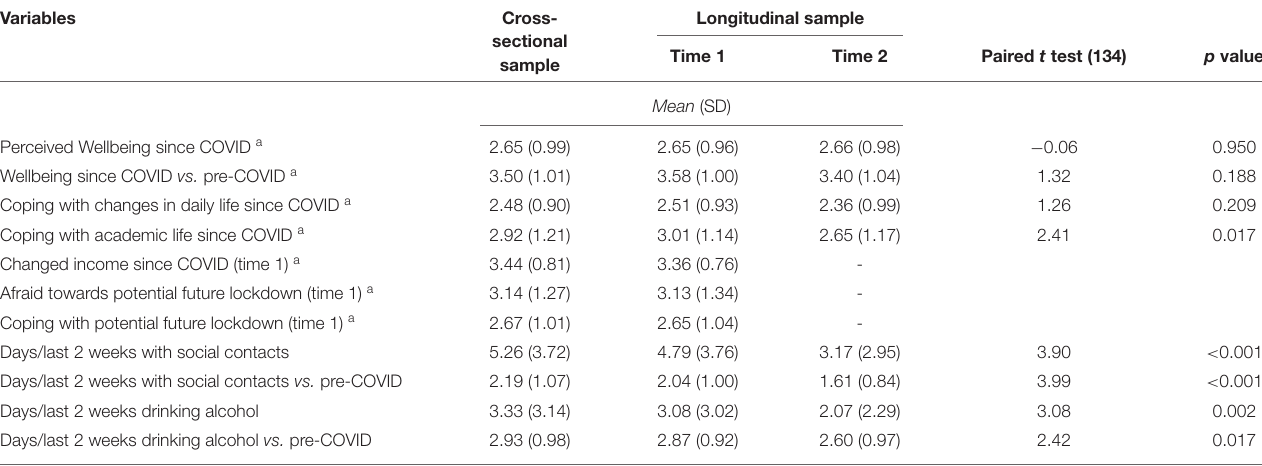
TABLE 2 | COVID-19 related responses and changes during the pandemic. Variables Cross-